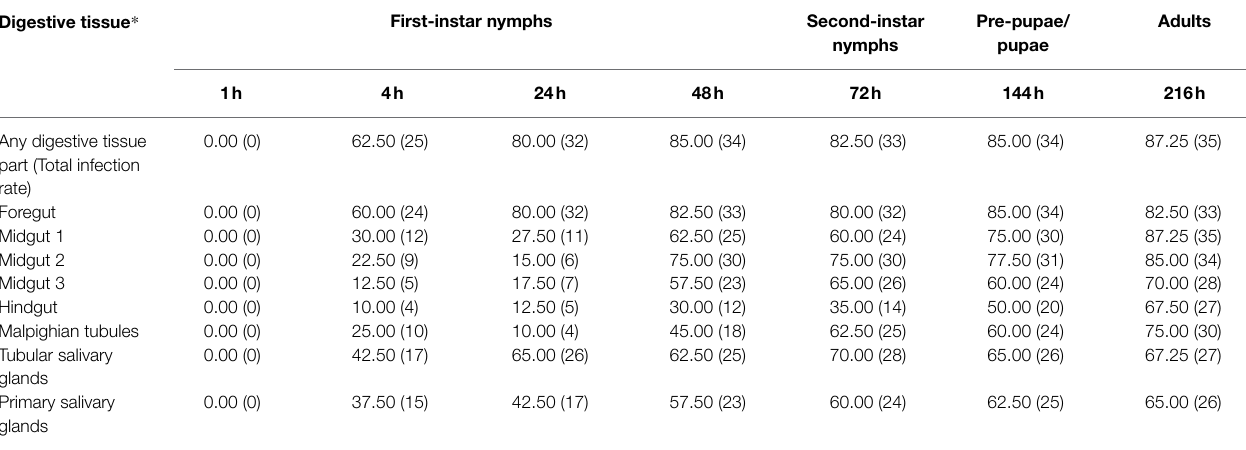
* First-instar F. occidentalis nymphs (12 h old) were fed for an acquisition access period of 12 h on TZSV-infected pepper leaves and transferred to freshly soaked beans. Forty digestive organs were dissected at 1, 4, 24, 48, 72, 144, and 216 h post-first access to diseased plants. TZSV-N-FITC was used to indicate the presence of TZSV by green fluorescence. The percentage of infection was determined for each tissue examined. Data in parentheses indicate the number of virus-positive